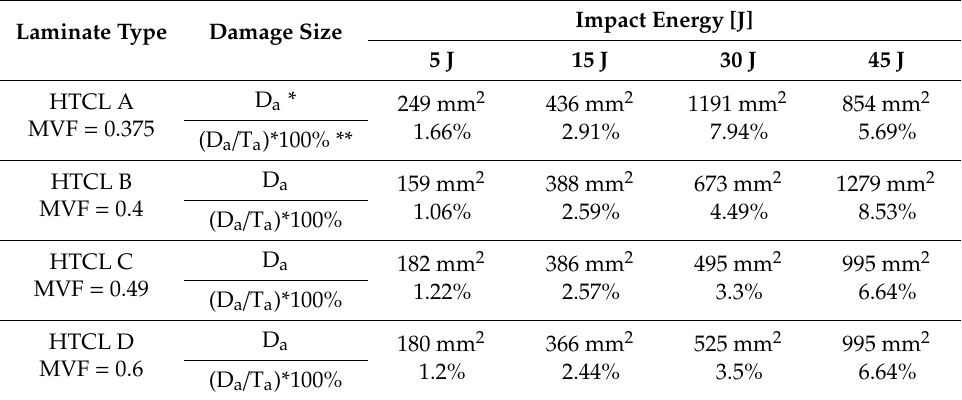
Table 5. Damage area of HTCL with various MVF after